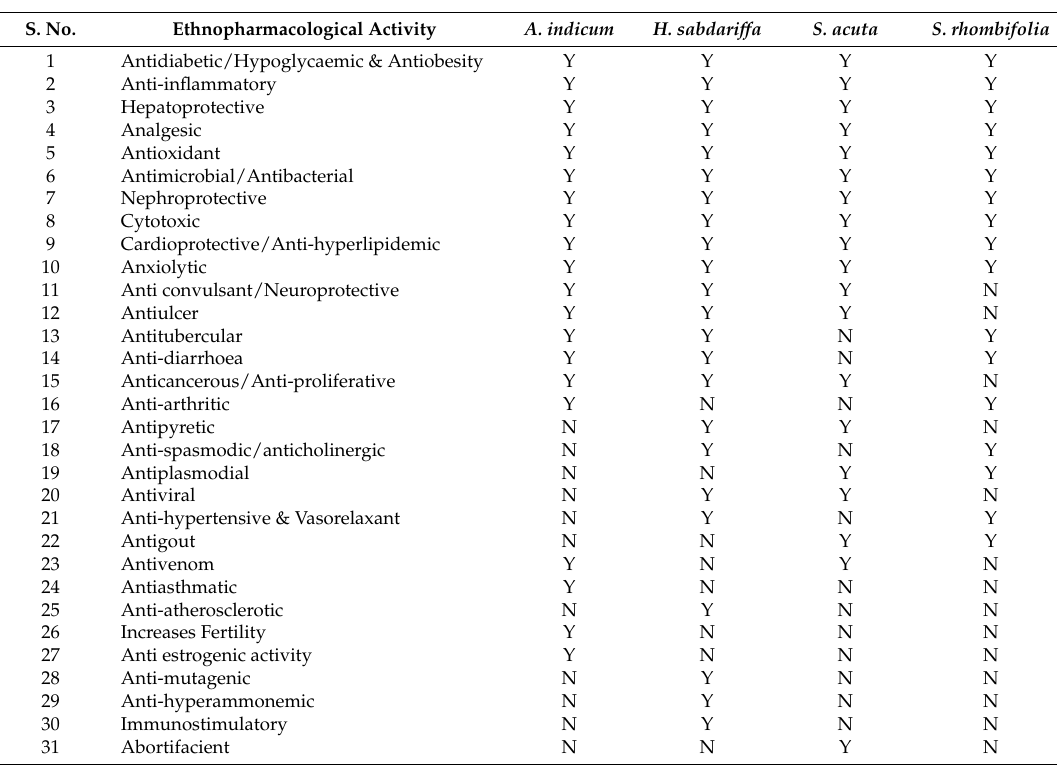
Table 2. Comparison of ethnopharmacological activities of Abutilon indicum , Hibiscus sabdariffa , Sida acuta and Sida rhombifolia (Y—Reported; N—Not reported).